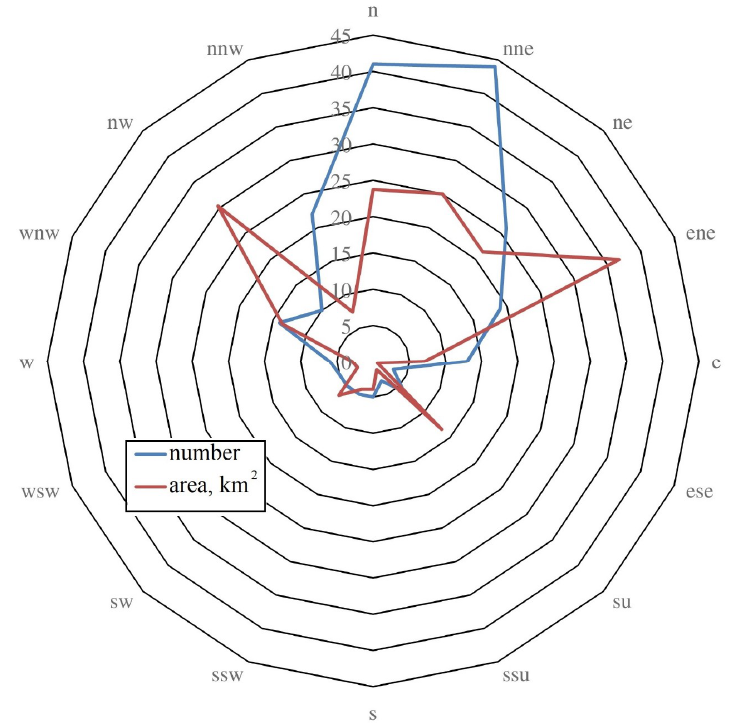
Figure 7. The aspect distribution of the number and area of glaciers in 2010.